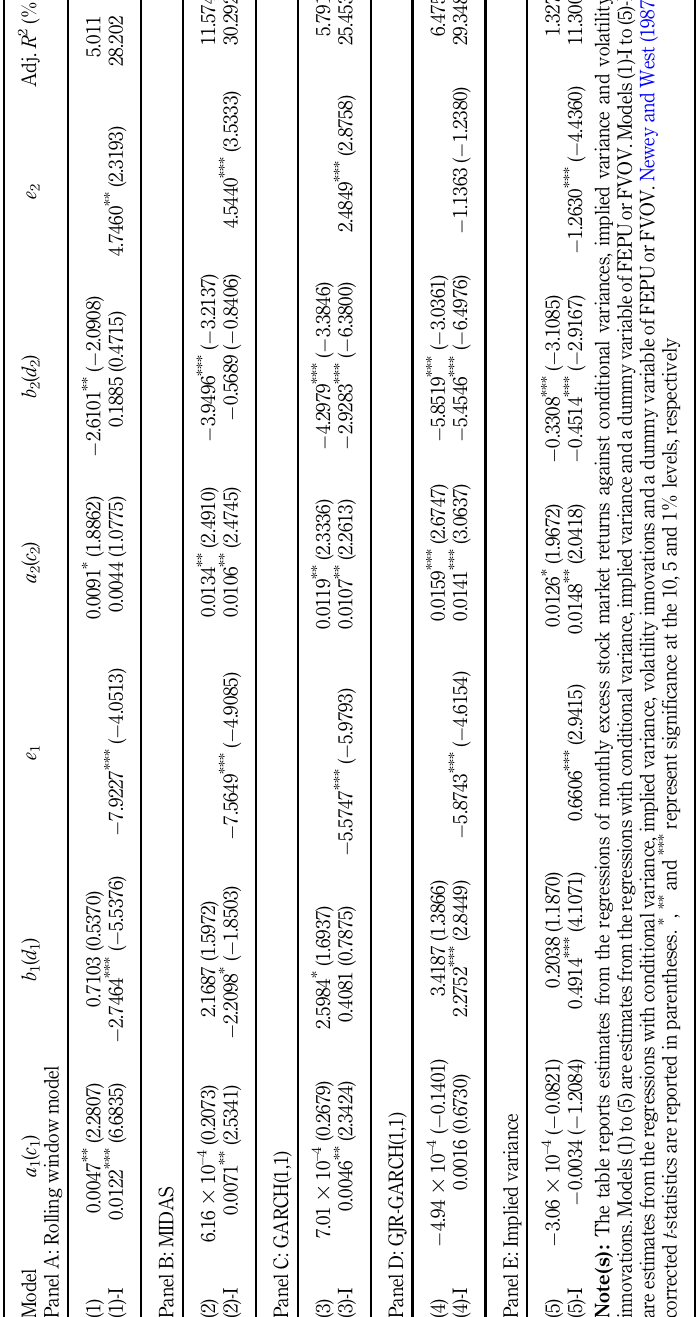
Table 6. Effectofchangingbase assets: Monthly excess stock market returns against conditional variances, implied variance and volatility innovations with